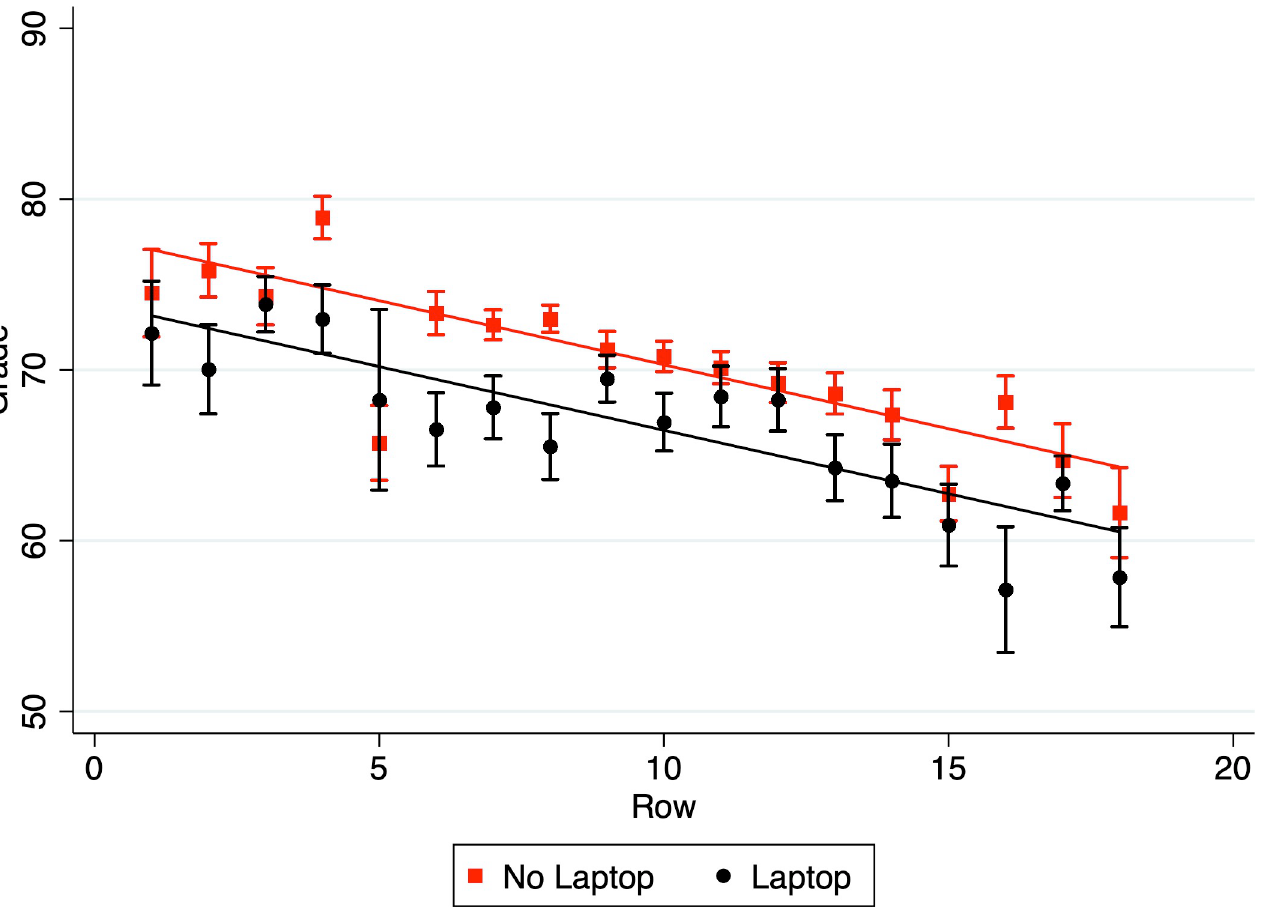
Fig 1. Relationship between grade, row and computer. Performance (Grade) is plotted against row in the lecture room, separately for students who used a computer and those who did not. For each row, the mean grade and standard errors are shown.